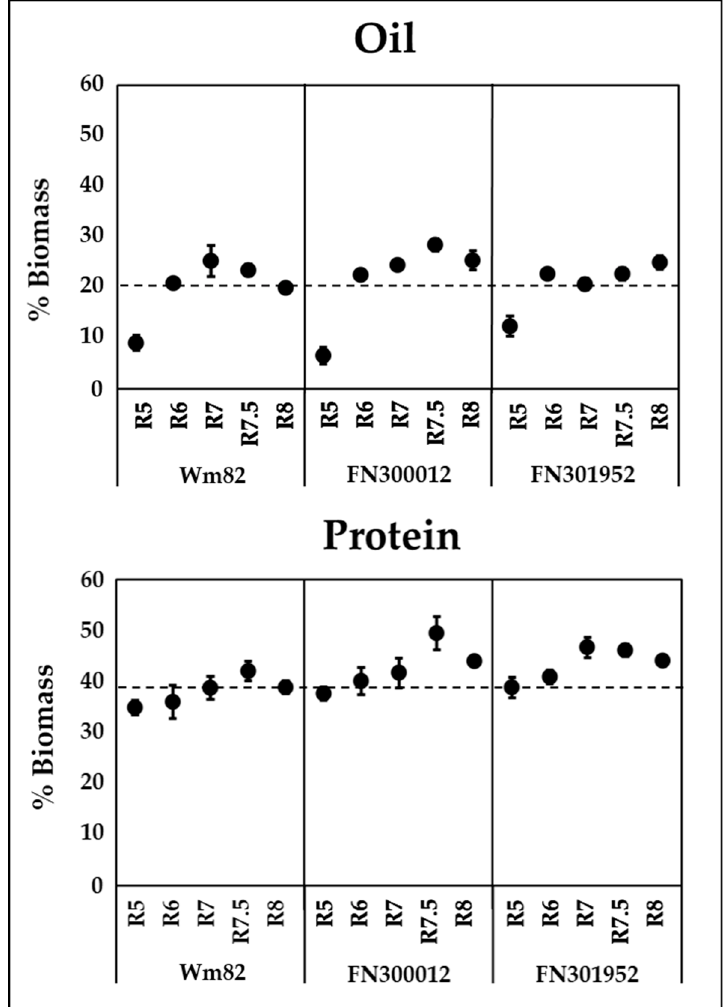
Figure 3. Oil (top panel) and protein (bottom panel) content in cotyledons over the course of development in two FN lines FN300012 and FN301952 compared to the wild-type Williams 82 (Wm82). Dotted lines represent the oil and protein quantities of the wild type at maturity for comparison. Error bars are the standard error of the mean (SEM), n = 6. Absolute values are presented in Table S3.